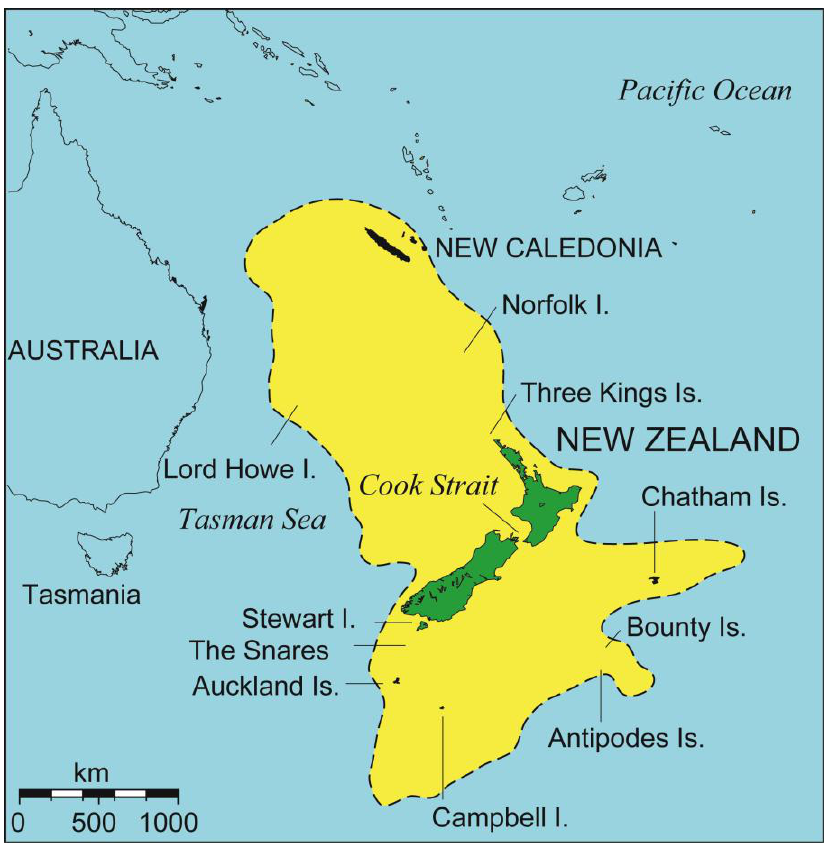
Figure 1. New Zealand‘s place in the Pacific. The approximate position of the largely submerged continental crust of Zealandia is indicated in